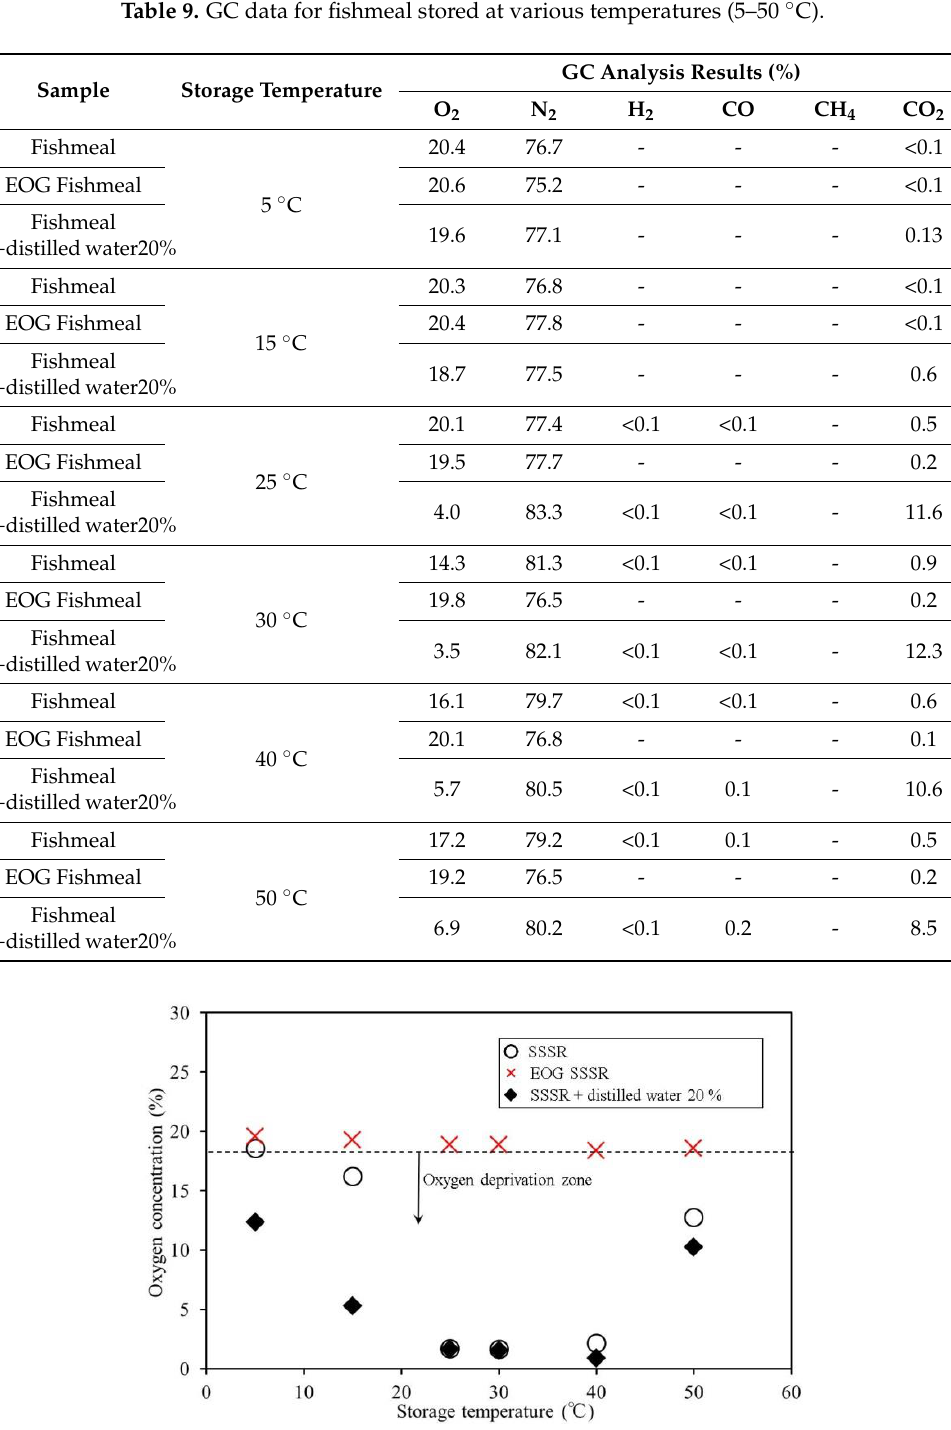
Figure 19. Carbon dioxide concentrations as functions of storage temperature for SSSR samples.